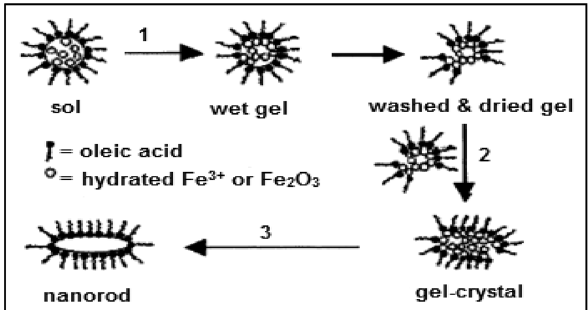
Figure 1: Schematic presentation of the formation of nanorods in the sol – gel method [ 48 ]